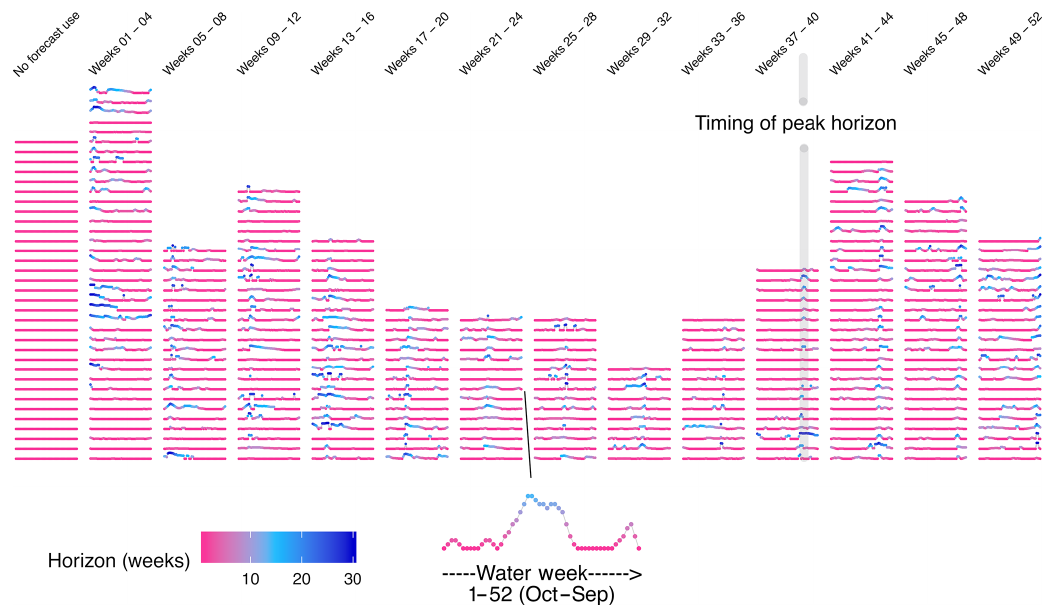
Figure 3. Horizon curves for 316 dams, binned according to timing of its peak horizon (i.e., the week of the water year where the longest- range foresight horizon is detected). Each horizon curve specifies the inferred operational horizon from water week 1 (week commencing 1 October, at the left of the horizon curve) to 52 (week commencing 24 September, at the very right of the horizon